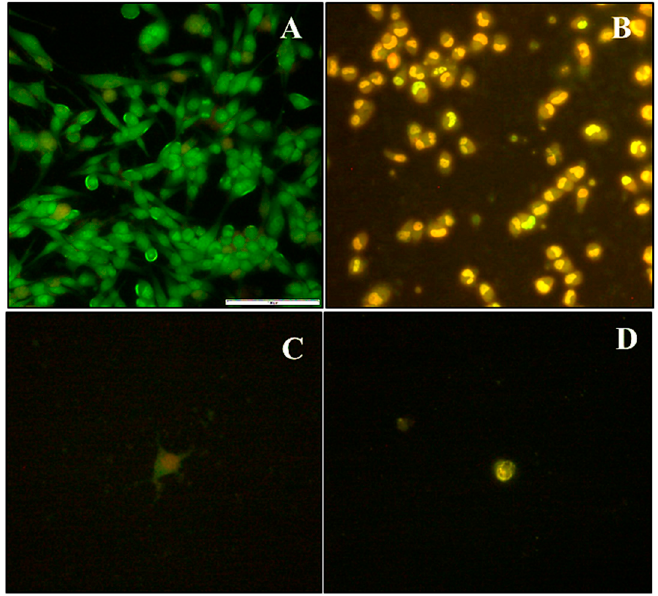
Figure 7. Selected fluorescent micrographs of dual acridine orange / ethidium bromide-stained cells showing induced morphological changes in ( A ) HEK293 cells, ( B ) Caco-2 cells treated with DOX loaded 2% PCMSN ( C ) MCF-7 cells treated with DOX loaded 5% PCMSN, and ( D ) HeLa cells treated with DOX loaded 5% PCMSN at 20× magnification.